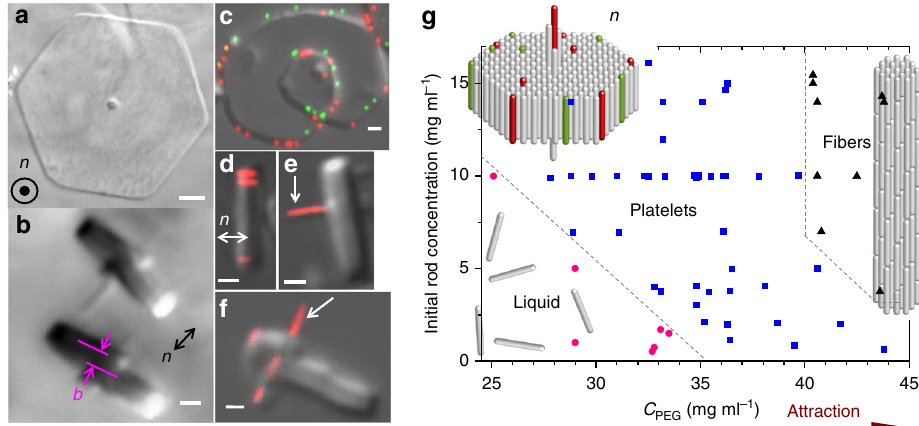
Fig. 1 Self-assembly of rod-like viruses by effective depletion attraction into two-dimensional crystalline colloidal platelets. a Face-on view by differential interference contrast (DIC) optical microscopy of a hexagonal platelet. The platelet main axis is indicated by n . b Side-on DIC image of two platelets penetrated by a long central columnar fi lament around which a screw dislocation with a Burgers vector of magnitude b ≈ 1 µ m has grown, resulting in some partial overlap of the one-rod-length-thick monolayer. c Helical platelet where the axial dislocation is seen from top-view, and decorated by red and green fl uorescently labeled viruses at its edges. Observation performed by overlaying DIC and fl uorescence images. d Composite DIC/ fl uorescence microscopy side-on image showing that platelets are composed of aligned fd rods within the whole crystalline structure, lying parallel to the platelet main axis, n . The addition of a low fraction of fl uorescently labeled viruses evidences the absence of tilt and therefore of twist at the platelet edges. e-f Fluorescence microscopy combined with DIC reveals that the central protruding needle-like core is composed of both single viruses and the low fraction of multimeric viruses (red dimers, as indicated by the white arrows) initially present in the suspension. Scale bars, 1 µ m. g The range of stability of hexagonal platelets is located between the isotropic phase of rods (fd-wt strain) and columnar fi bers, by increasing depletion